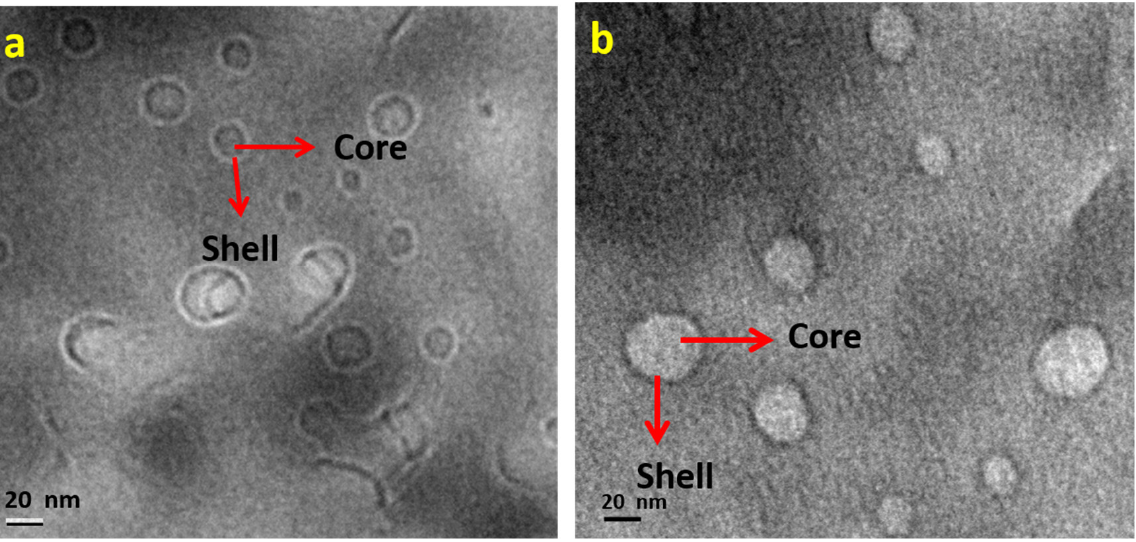
Figure 1. HR-TEM images of ( a ) 10 phr and ( b ) 20 phr epoxy/eSBS 55 blends.